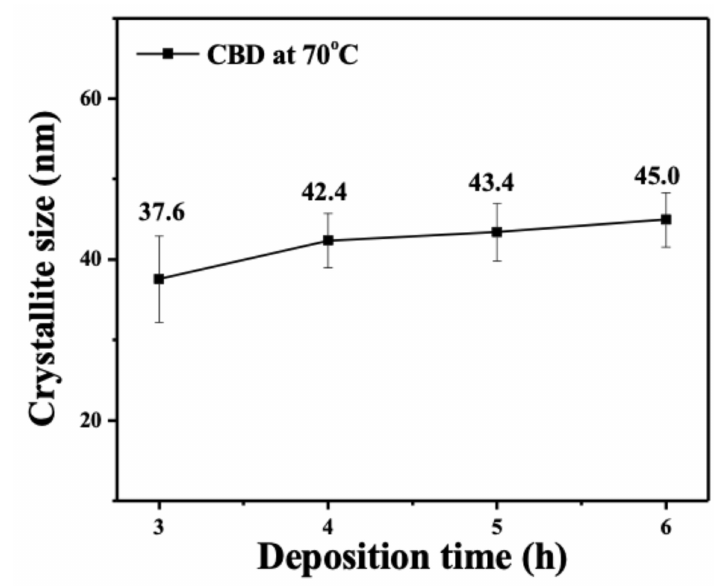
Figure 3. Crystallite size of the ZnO nanorods deposited under growth condition of pH = 6 by chemical bath deposition (CBD) at 70 ◦ C as a function of deposition time.